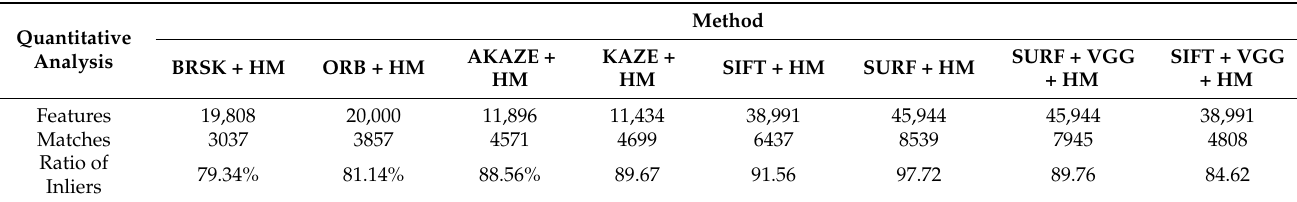
Table 2. Statistical results (correct matches) of the Semper sequence of Strach’s dataset, where HM represents HashMatch, “SURF + VGG” represents SURF detector and VGG descriptor, and “SIFT + VGG” represents SIFT detector and VGG